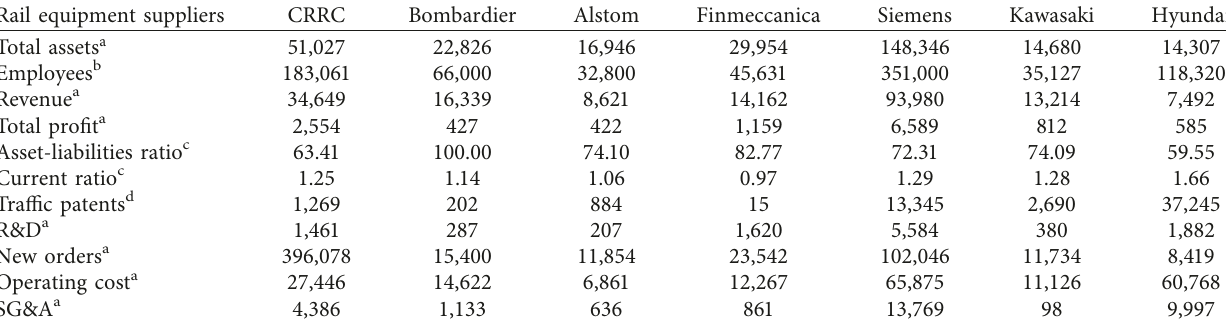
Table 6: Data of rail equipment